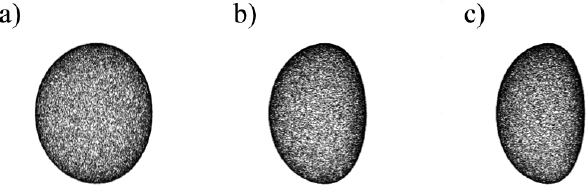
Fig. 4. Chebyshev particles ( D = 50µm) with varying area ratios of (a) 0.85, (b) 0.77, and (c) 0.69.